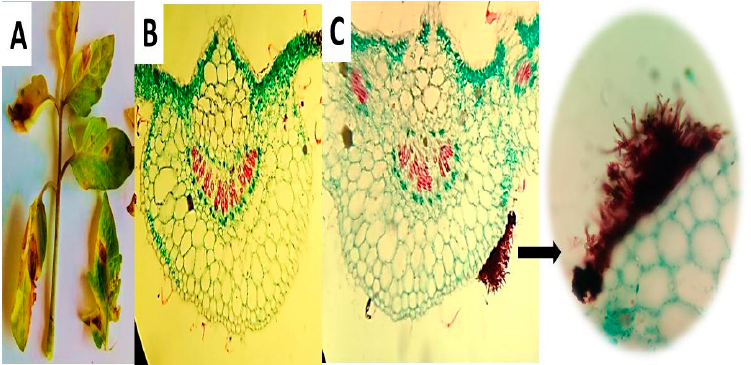
Figure 1. Dark spot lesions generated by Alternaria cerealis (MT808477) pathogen in tomato leaves ( A ); transverse sections of the healthy leaf region ( B ); and infected leaf region showed brownish fungal conidiophores and mycelia on the leaf surface ( C ) using light microscope (LM).